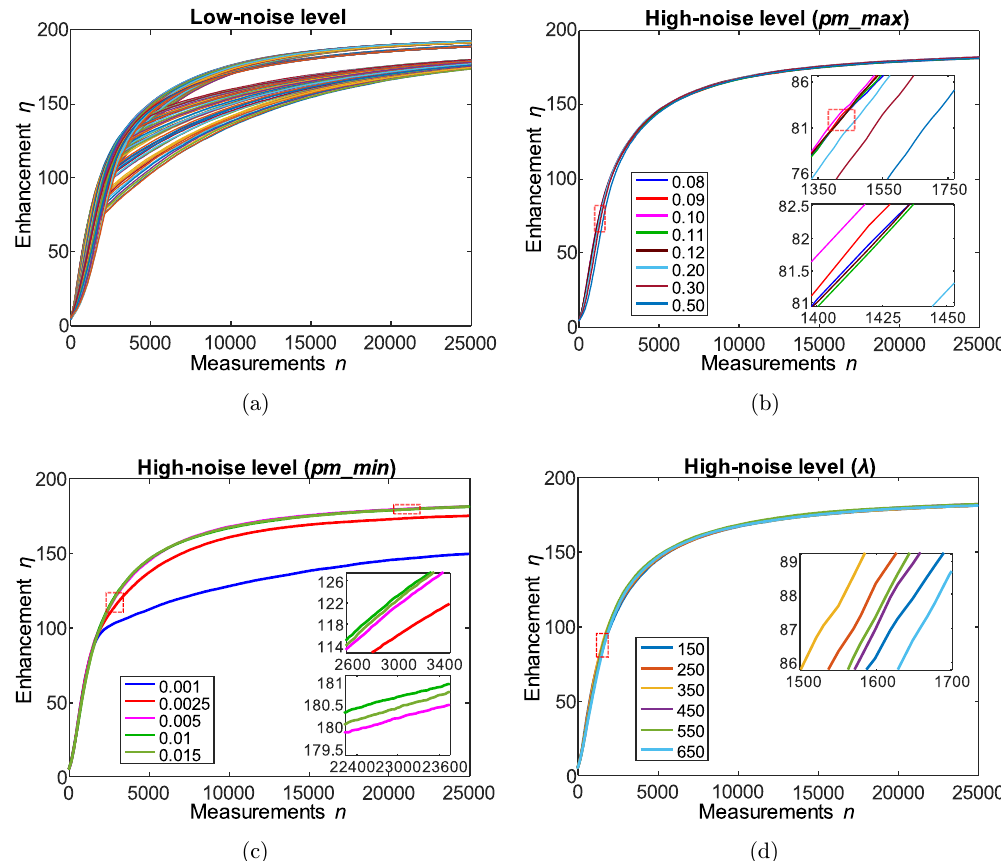
Fig. 6. Comparisons of di®erent choices of the mutation rate pm at high-noise level. (a) Coplot of the performance of the GA with 240 di®erent combinations of the parameters high-noise level. (b) – (d) The enhancement as a function of the number of measure- ments when only pm max , pm min , and (cid:2) are varied, respectively. Insets are provided for visualization